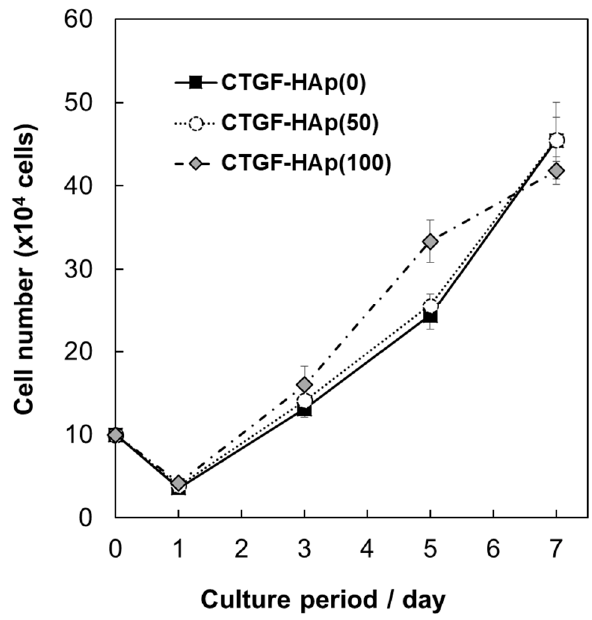
Figure 3. Cell proliferation on CTGF-loaded HAp ceramics. To examine the effect of proliferation on osteoblasts by CTGF, cells were cultured on CTGF-HAp ceramics for seven days. The number of proliferating cells was counted at day 1, 3, 5, and 7 after plating. Experiments were repeated three times and run in triplicate. Graphs represent means ± SD.